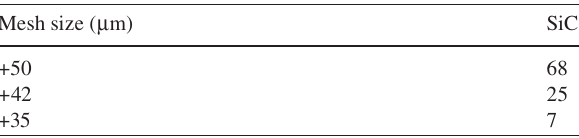
Table 2 Particle size fraction of the SiC ( % ).